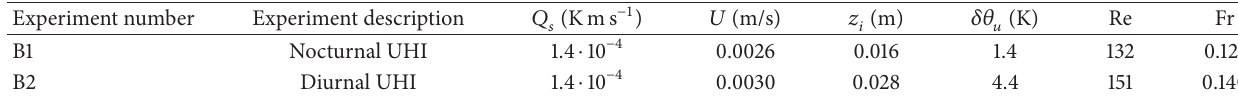
Table 3: Parameters for the UHI experiments, including the observed values of mixing height 𝑧 𝑖 and UHI intensity 𝛿𝜃 𝑢 = (𝜃 𝑄 𝑠 is the surplus of surface heat flux. The heater dimensions and the buoyancy frequency cases. For case B2 the surface heat flux was 7.2 ⋅ 10 −5 Kms −1 . The duration of the experiments is roughly 800 s.